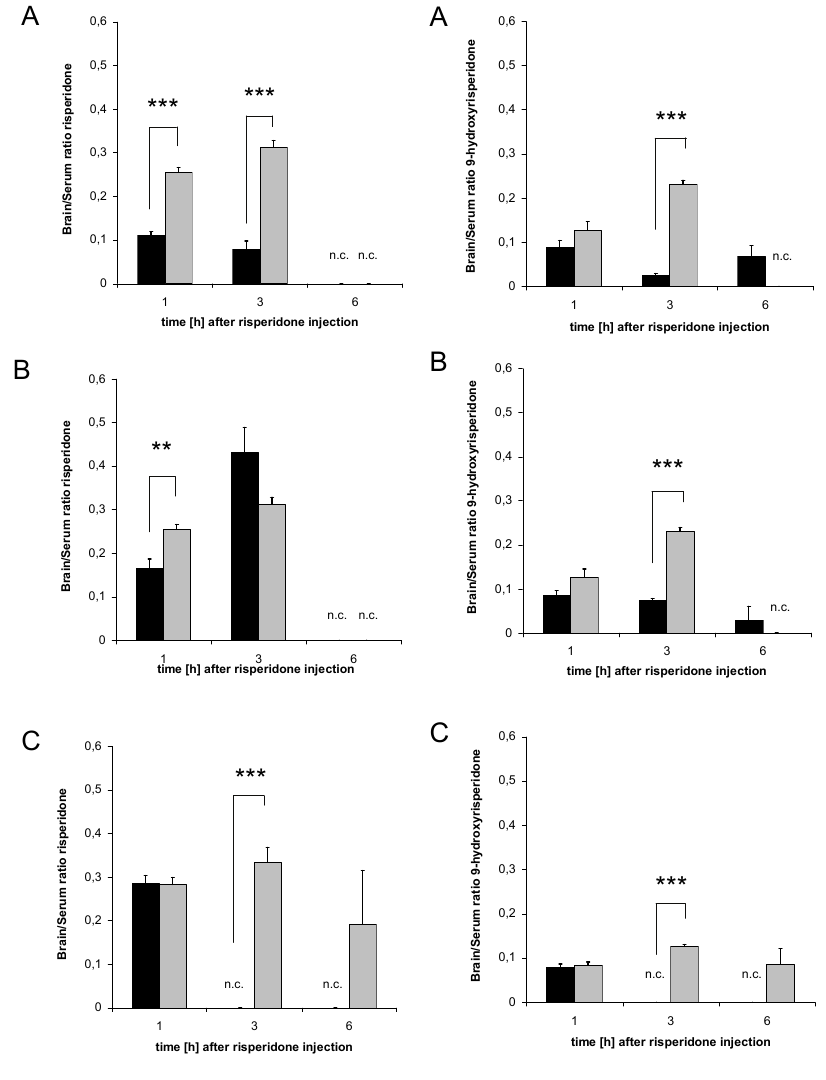
Figure 7. Brain/Serum ratio. Brain/Serum ratio of risperidone (left side) and 9-hydroxyrisperidone (right side) after treatment with 10 mg/kg/d rifampicin (A), 50 mg/kg/d dexamethasone (B) or 25 mg/kg/d PCN (C) vs. controls. Data presented are mean + /- S.E.M. (** p < 0.01; *** p < 0.001). n.c. = data not calculable due to division by zero, and set to zero for statistical calculations.